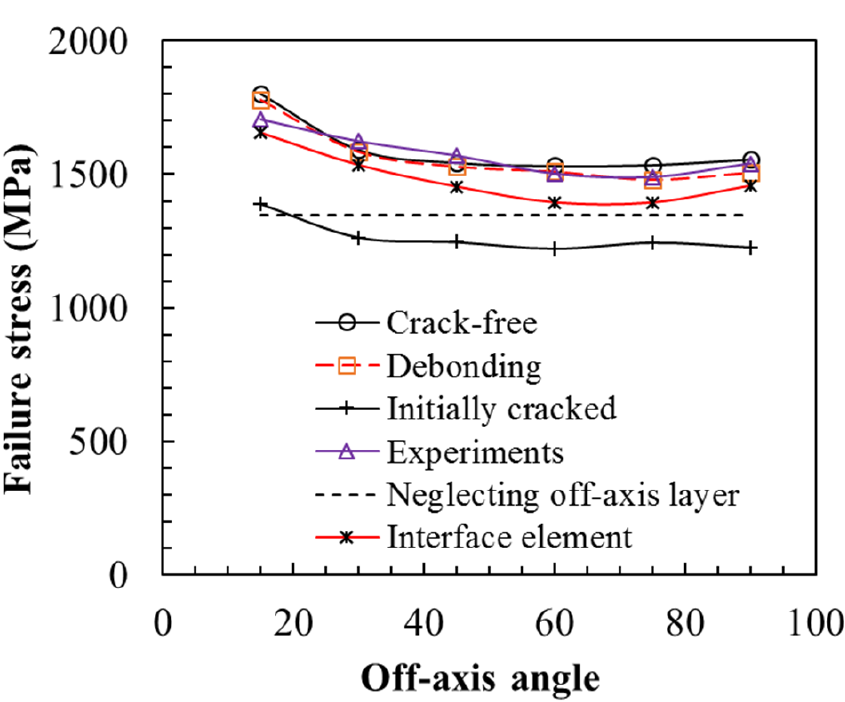
Figure 12. Numerical results of a series of FEA models compared to the experimental results.